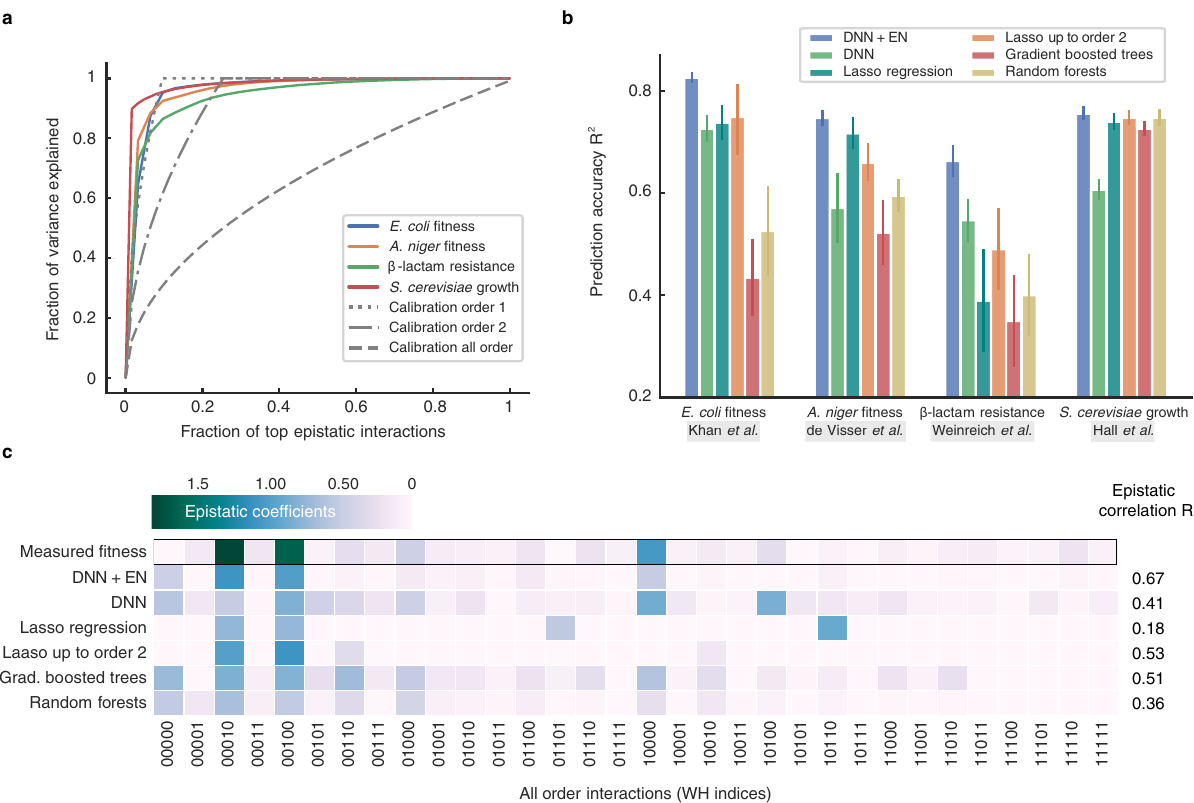
Fig. 2 Predicting bacterial fi tness and inferring epistatic interactions in four canonical landscapes. a Fraction of variance explained by the top WH coef fi cients revealing the sparsity in the bacterial fi tness functions. b Prediction accuracy of deep neural network (DNN) with Epistatic Net (EN) regularization against competing models in ML. The error bars show the standard error of the mean (SEM) across 20 independent repeats of the experiments with random split of the data into training, validation, and test sets. c Visualization of the epistatic interactions of DNN with and without EN regularization and the baseline models after training on Escherichia coli fi tness landscape of Khan et al. 9 . R 2 values show the correlation of the recovered epistatic interaction with the interactions in the measured combinatorial Escherichia coli fi tness